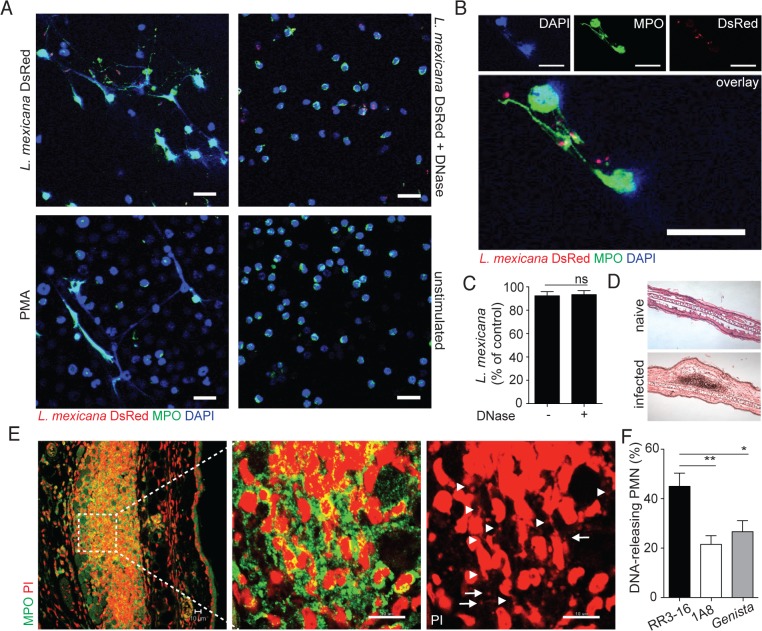
Induction of NETs by L. mexicana promastigotes.(A) Sorted mouse BM neutrophils were adhered on poly-L-lysin coverslips and incubated for 4 hours with L. mexicana-DsRed metacyclic promastigotes at a 5:1 parasite-cell MOI in absence or presence of DNase 10μg/mL. Samples were fixed, stained for MPO and DNA (DAPI) and analyzed by confocal microscopy. As controls, neutrophils were incubated with 100ng/mL PMA or medium and similarly analyzed. (B) Higher magnification of L. mexicana-DsRed-induced NETs. (C) BM neutrophils were incubated with L. mexicana-luciferase promastigotes at a 5:1 parasite-cell MOI in absence or presence of 10μg/mL DNase. After 4 hours parasite survival was determined in each group by dividing the luciferase relative light units (RLUs) obtained in presence of neutrophils from that obtained in the absence of neutrophils. (D) RR3-16-treated, 1A8 PMN-depleted C57BL/6 and Genista mice were inoculated i.d. with 106 metacyclic L. mexicana. Ears were collected 24h later and histology performed on 4 micron sections and inflammatory cell recruitment determined by hematoxylin and eosin. (E) Ear sections were stained with polyclonal anti-MPO Ab and DNA stained with PI. Arrowheads point to neutrophil DNA fibers and arrows to parasite DNA. (F) Frequency of neutrophils producing NETs/section as determined by confocal microscopy. Data presented as mean ± SEM for n ≥ 4/group. Results representative of 3 or more independent experiments. Scale bars: 10 micron. * p<0.05 ** p<0.01, ns: non significant.